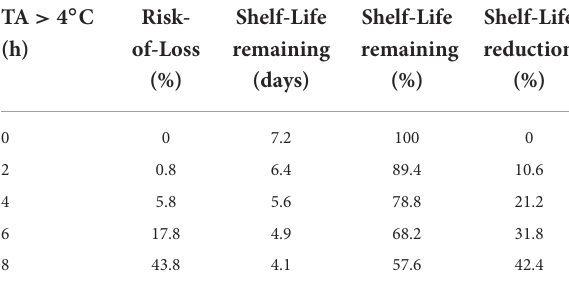
TABLE 2 Monte Carlo derived shelf-life predictions for cyclically temperature abused (TA; 2h at 4 ◦ C then 2h at 25 ◦ C) chicken breasts filets determined by time (h) spent above 4 ◦